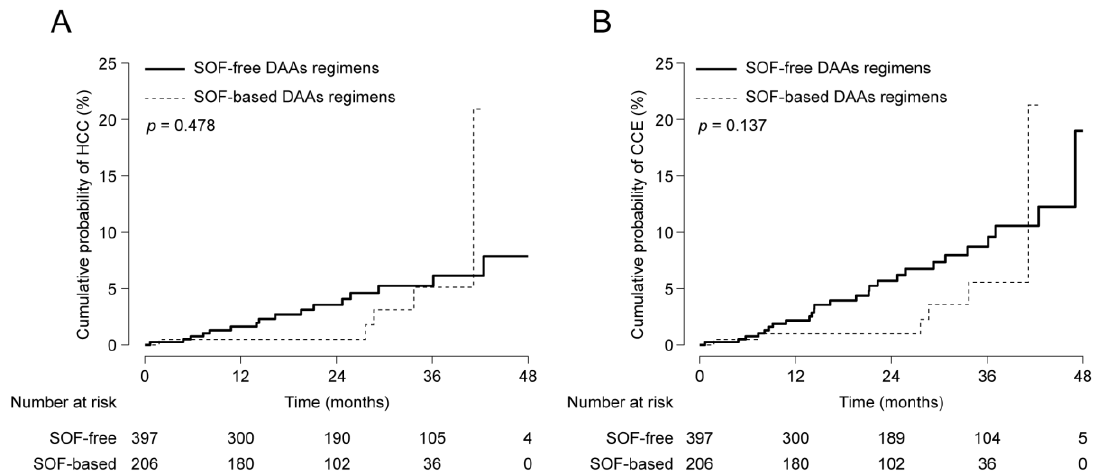
Figure 3. Cumulative probabilities of HCC ( A ) and CCE ( B ) development between patients treated with the SOF-based and the SOF-free DAAs regimens before statistical adjustment.